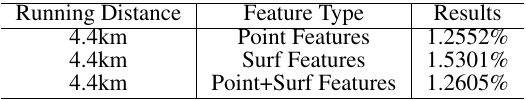
Table 1. The Ablation Study Of Lidar Features